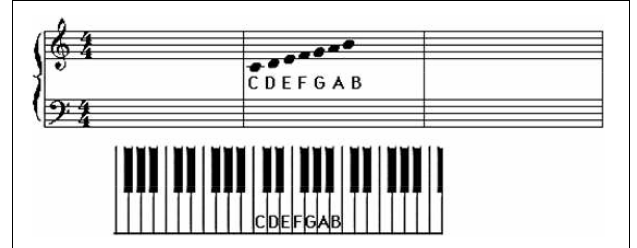
FIGURE 6 | The effect of OMR system note detection and recognition.